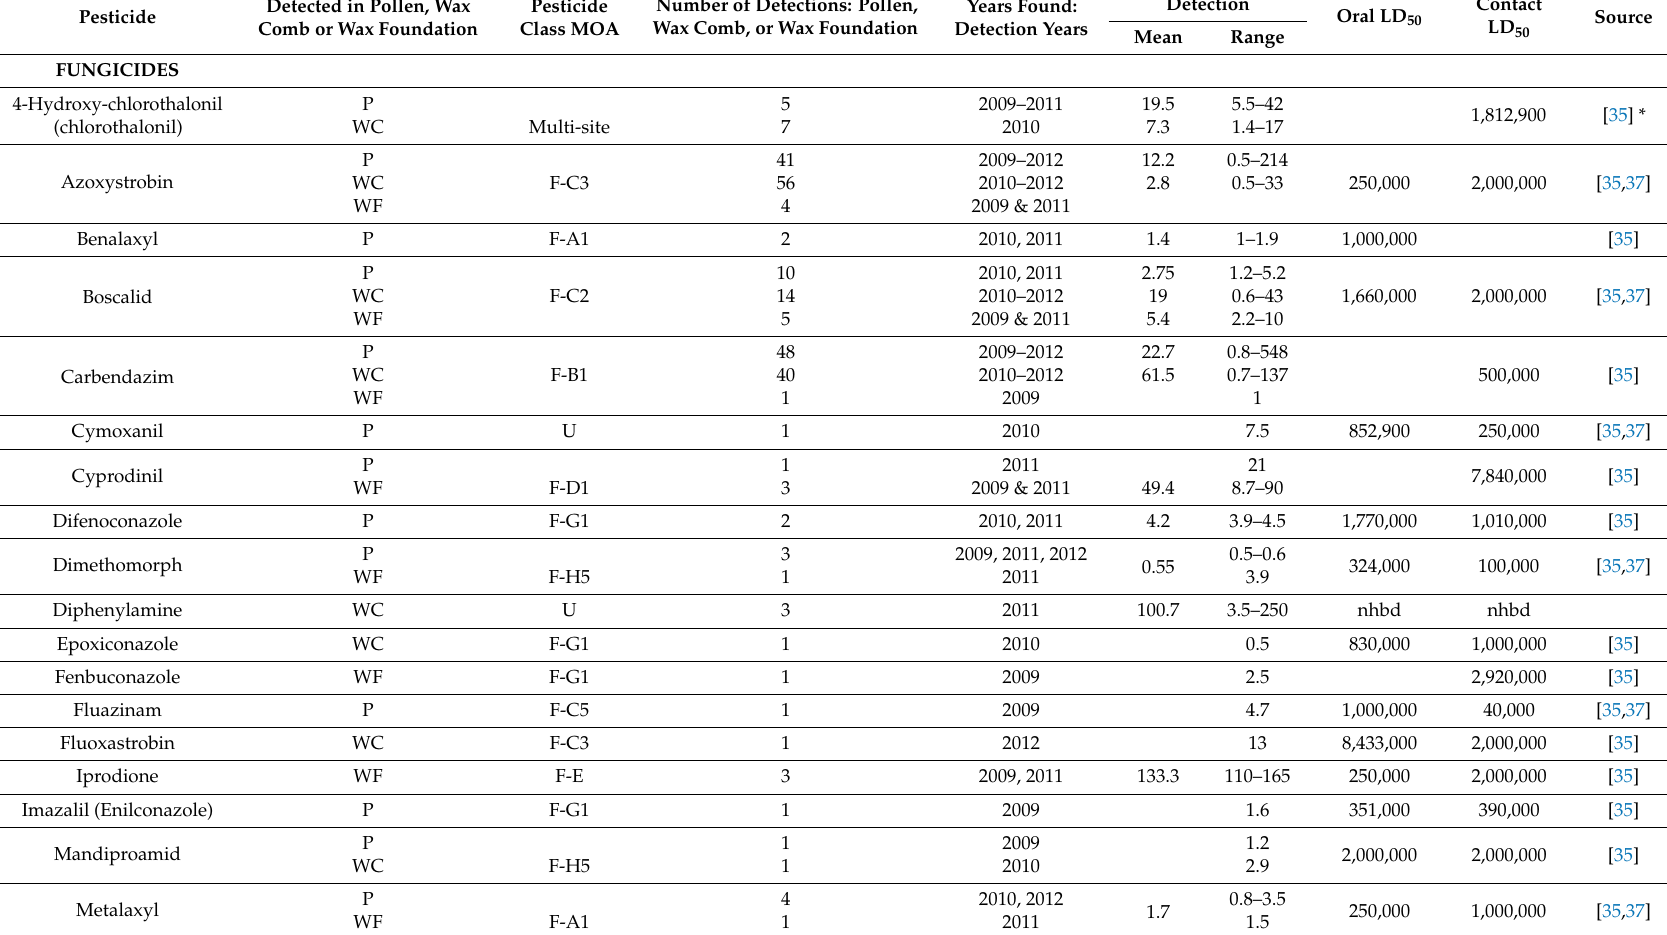
Table 2. Honey bee contact and oral LD 50 for 91 compounds detected in pollen (P) wax comb (WC) and wax from coated foundation (WF). Mean, range, and LD 50 values reported as ppb. The LD 50 for the parent compound was used for a detected metabolite. Abbreviations: F = fungicide; H = herbicide, I = insecticide; U = unknown mode of action (MOA); nhbd = no honey bee data available. See Section 3.1 for